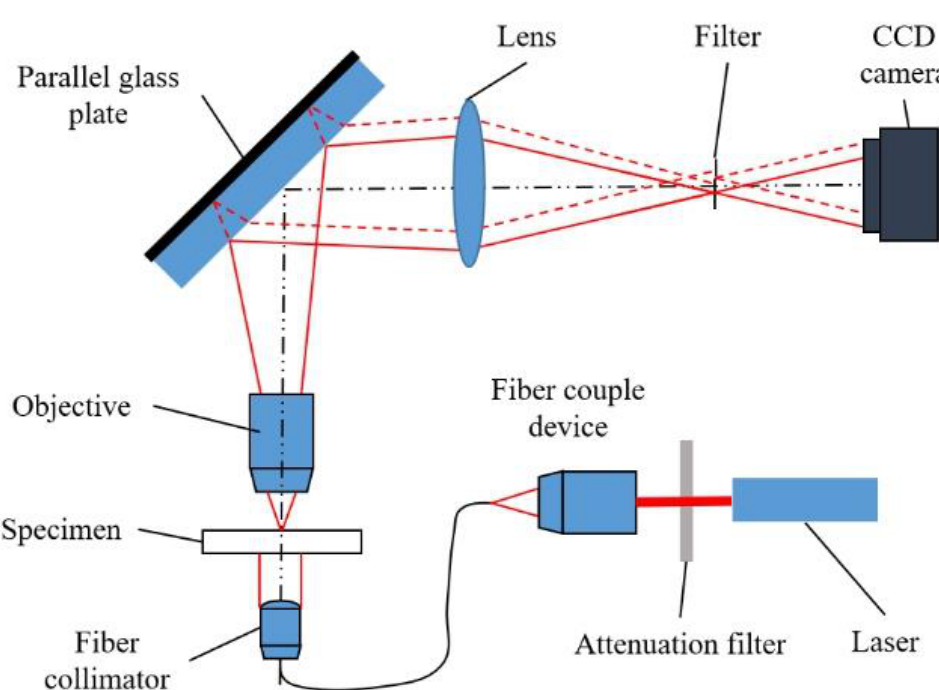
Figure 1. The experimental configuration for wavelength-tuning common-path digital holographic microscopy (DHM).